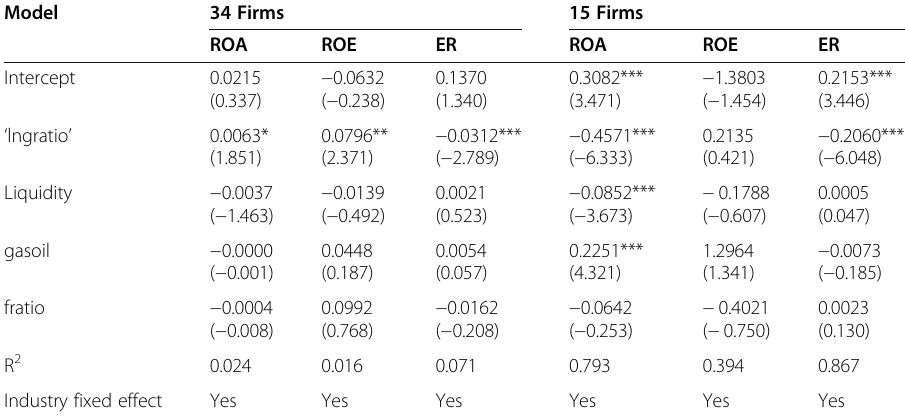
Table 6 Financial performance of the 34 and 15 shipping firms by including freight ratio Model 34 Firms 15 Firms